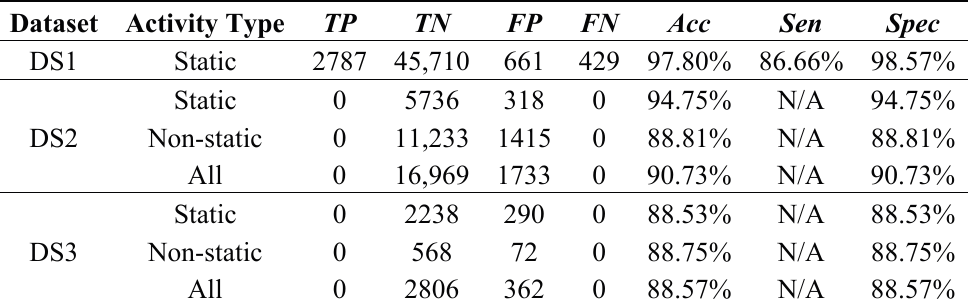
Table 10. Evaluation results: Arrhythmia classification.